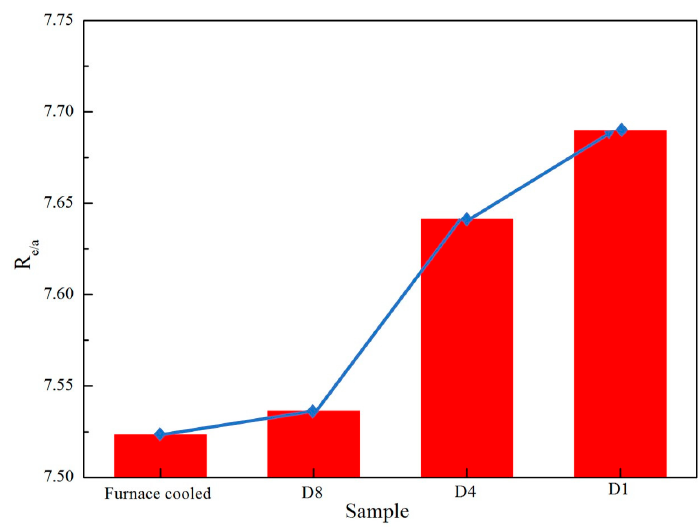
Figure 7. R e/a of Co 33 Ni 31 Al 27 Fe 9 alloy with furnace cooled and RS.